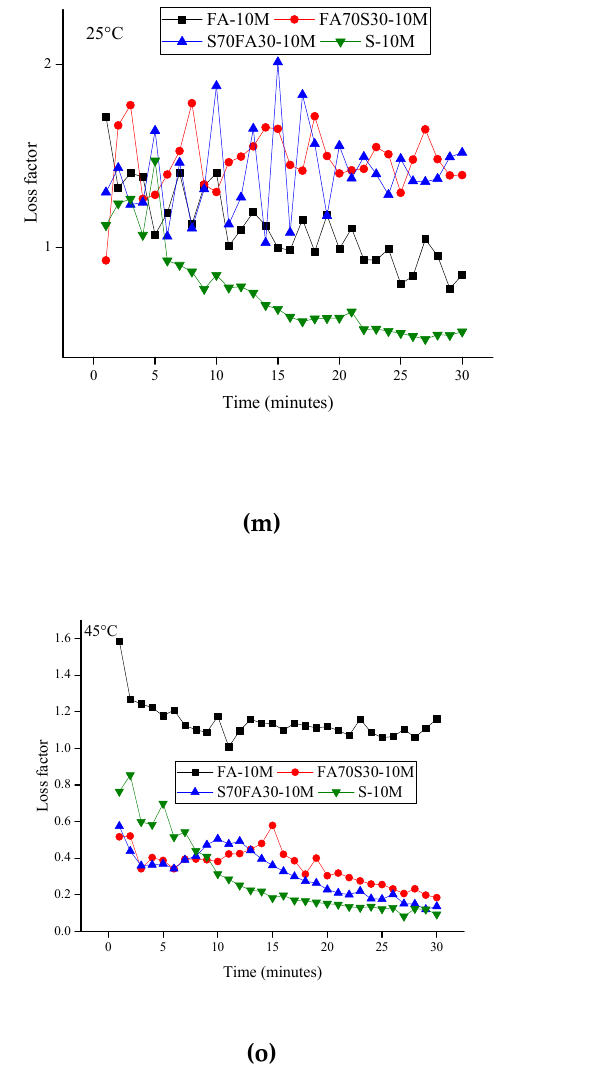
Figure 5. Evolution of loss factor with time for alkali-activated mixes: ( a ) 4M at 25°C; ( b ) 4M at 35°C; ( c ) 4M at 45°C; ( d ) 4M at 55°C; ( e ) 6M at 25°C; ( f ) 6M at 35°C; ( g ) 6M at 45°C; ( h ) 6M at 55°C; ( i ) 8M at 25°C; ( j ) 8M at 35°C; ( k ) 8M at 45°C; ( l ) 8M at 55°C; ( m ) 10M at 25°C ( n ) 10M at 35°C ( o ) 10M at 45°C; ( p ) 10M at 55°C.